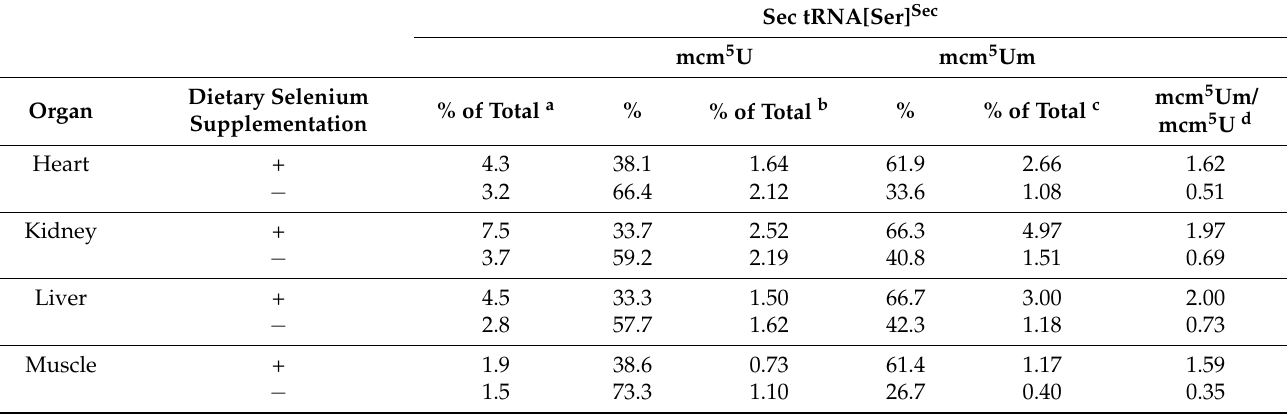
Table 2. Sec-tRNA[Ser] Sec isoforms in murine